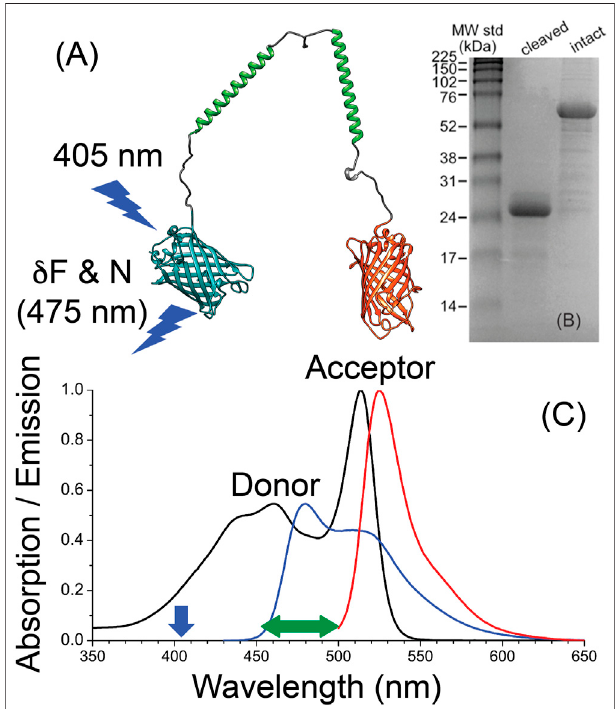
FIGURE 1 | A schematic structure, SDS-PAGE gel, and steady-state spectroscopyofcrTC2.1construct(mTurquoise2.1-linker-mCitrine)(Liuetal., 2018) (A) The structure of crTC2.1 (mTurquoise2.1-linker-mCitrine), where the amino acid sequence of the linker region is – (GSG) 6 A (EAAAK) 6 A (GSG) 6 A (EAAAK) 6 A (GSG) 6 – (B) SDS-PAGE of the intact and cleaved construct, which shows the corresponding molecular weight and the ef fi ciency of enzymatic cleavage reaction (C) The absorption and emission spectra of mTurquoise2.1-linker-mCitrine in a buffer, where the excitation (vertical arrow) and detection (horizontal arrow) of the donor in these FCS studies are